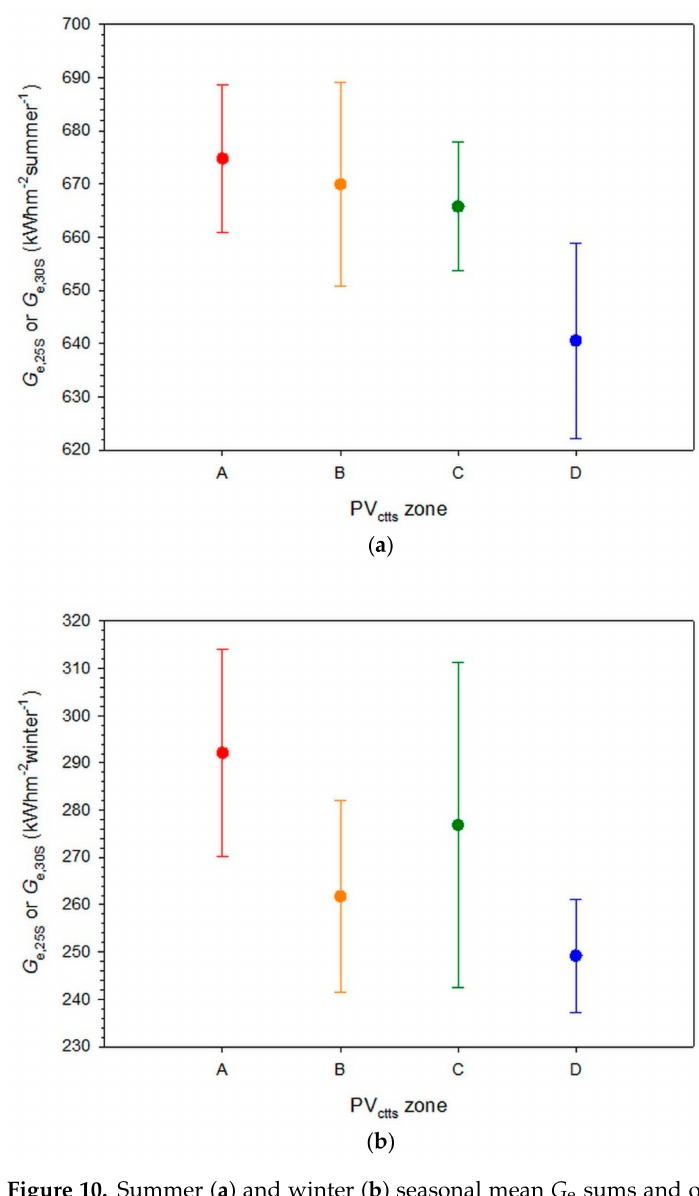
Figure 10. Summer ( a ) and winter ( b ) seasonal mean G e sums and one standard deviation ( ± 1 σ ) from the mean solar energy, received on a surface with a south-facing inclination of 25 ◦ or 30 ◦ . The seasonal solar energy values are the averages over all sites that belong to the same PV ctts